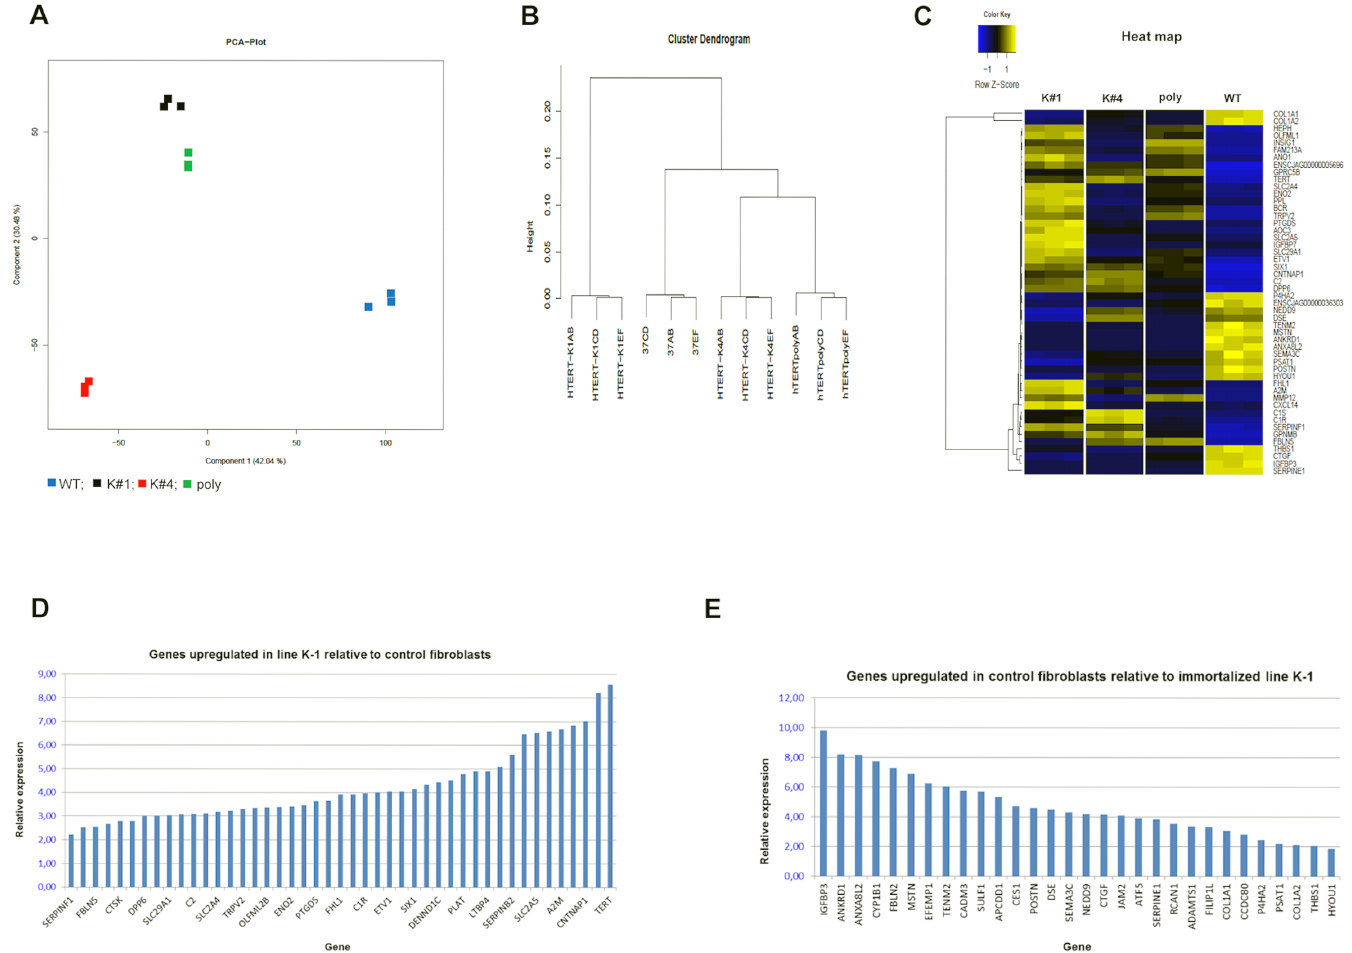
Fig 4. Transcriptome analysis of immortalized marmoset fibroblasts. (A) PCA-plot of a polyclonal (poly), two monocolonal (K#1 and K#4), and one wild-type (WT) control fibroblasts lines. (B) Cluster dendrogram showing that line K#1 clusters farther from the control relative to the other two immortalized lines. (C) Heat map showing the top 50 most significant differences in the gene expression between the WT and K#1. (D) Genes upregulated in immortalized monoclonal line K#1 relative to WT (all p-values = 0.00). (E) Genes expressed higher in WT cells relative to line K#1 (all p-values = 0.00).